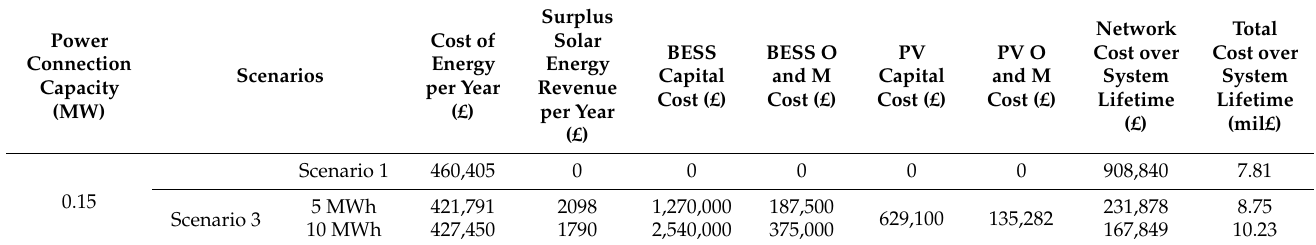
Table 7. System cost at for scenario 1 and scenario 3 (with a BESS of 10